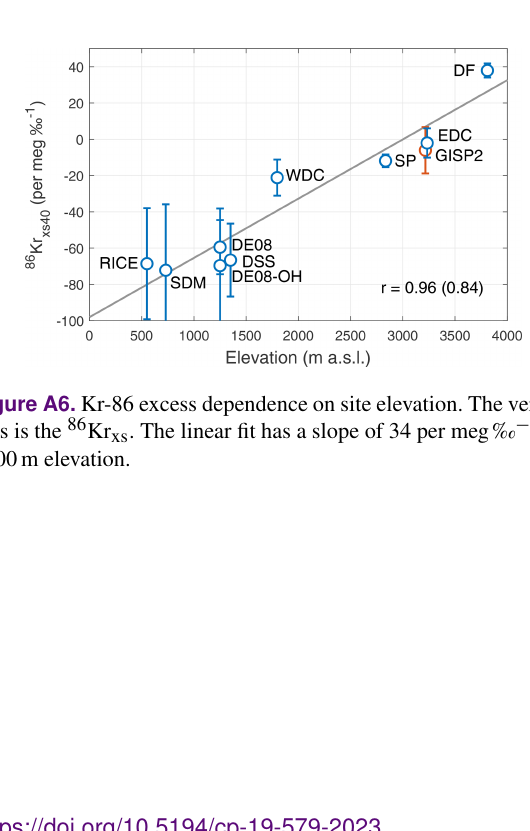
Figure A5. Gas loss and thermal corrections for the WDC time se- ries. (a) WDC gravity-corrected δ O 2 / N 2 – δ Ar / N 2 as a measure of gas loss. The solid line is a third-order polynomial fit to the data; the dashed lines give a ± 1‰ range around the fit, which captures the majority of the data. (b) The (cid:49)T correction applied to the downcore records. The blue envelope shows the ± 2 σ range of thermal correc- tion scenarios in the Monte Carlo sampling, together with the mean (blue line). Gray dots show WDC (cid:49)T estimates from available 15 N excess data, with the red curve being a Gaussian smoothing function to the data.